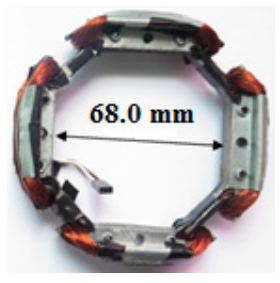
Figure 7. Prototype generator set.